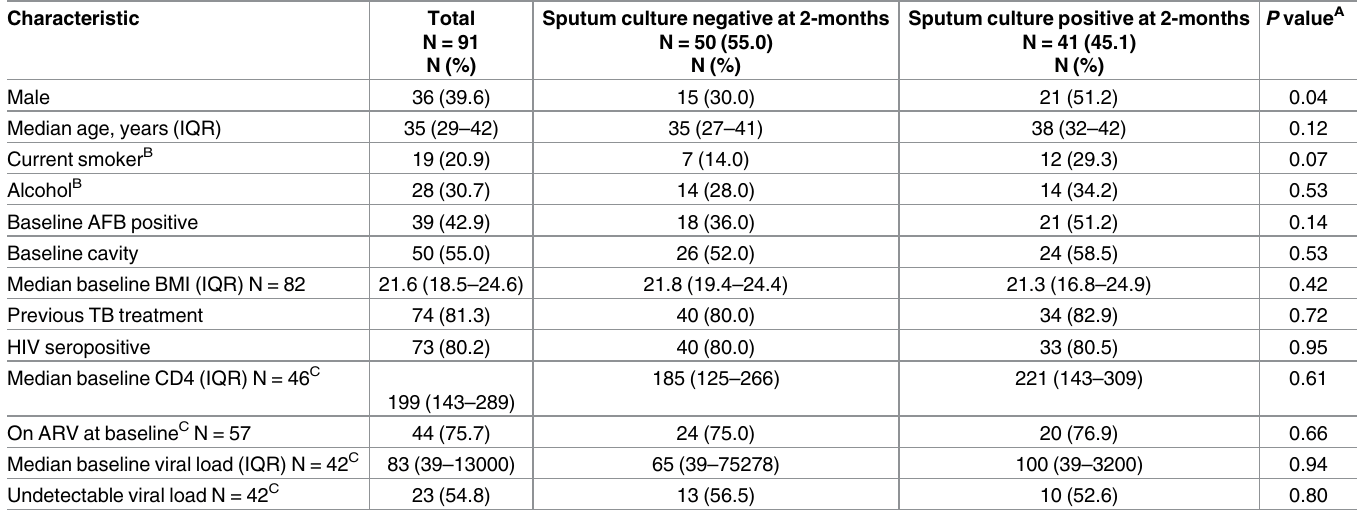
Table 1 abbreviations: IQR-interquartile range; AFB-acid fast bacilli; ARV-antiretroviral A. 2-side chi-square p-value, except for age (2-sided Wilcoxon rank